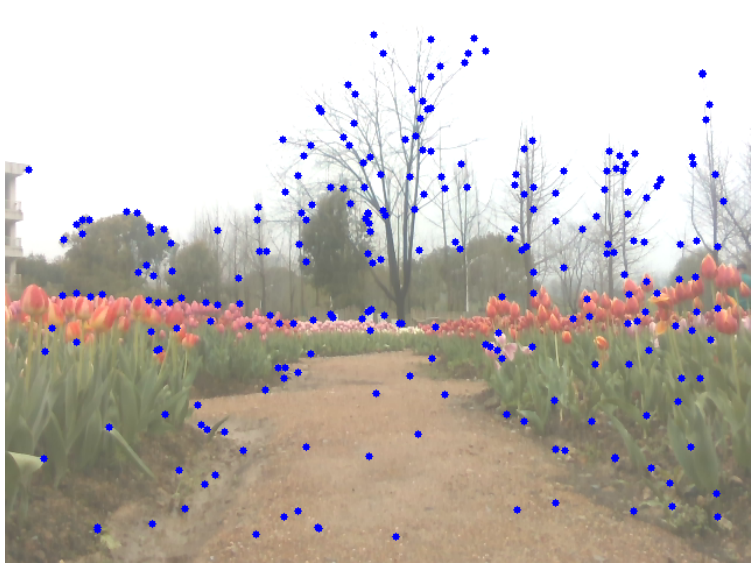
Figure 6. Extraction effect of uniform ORB feature points.